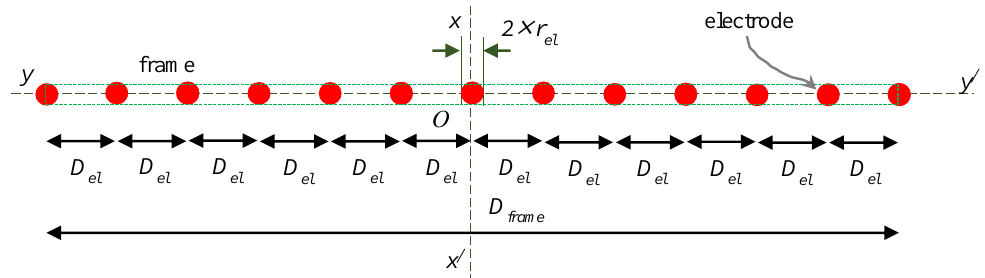
Figure 7. Typical frame view with 13 electrodes placed in series, vertically positioned, parallel to the yOy' axis.